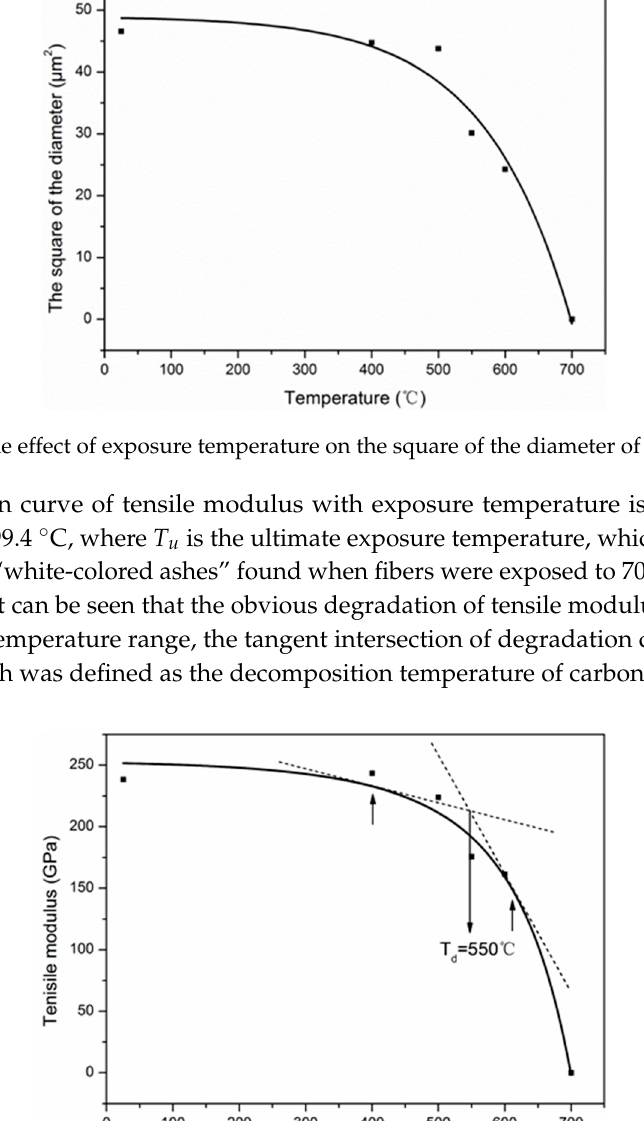
13 of 22 Figure 11. The dependence of the exposure temperature on the radial distribution of tensile modulus of carbon fibers . With the increase of exposure temperature, the diameter of carbon fiber was etched by oxidation from the outer layer to the core layer. Similarly, an exponential decay model was applied to describe the variation of diameter, as follows: 22 ( )